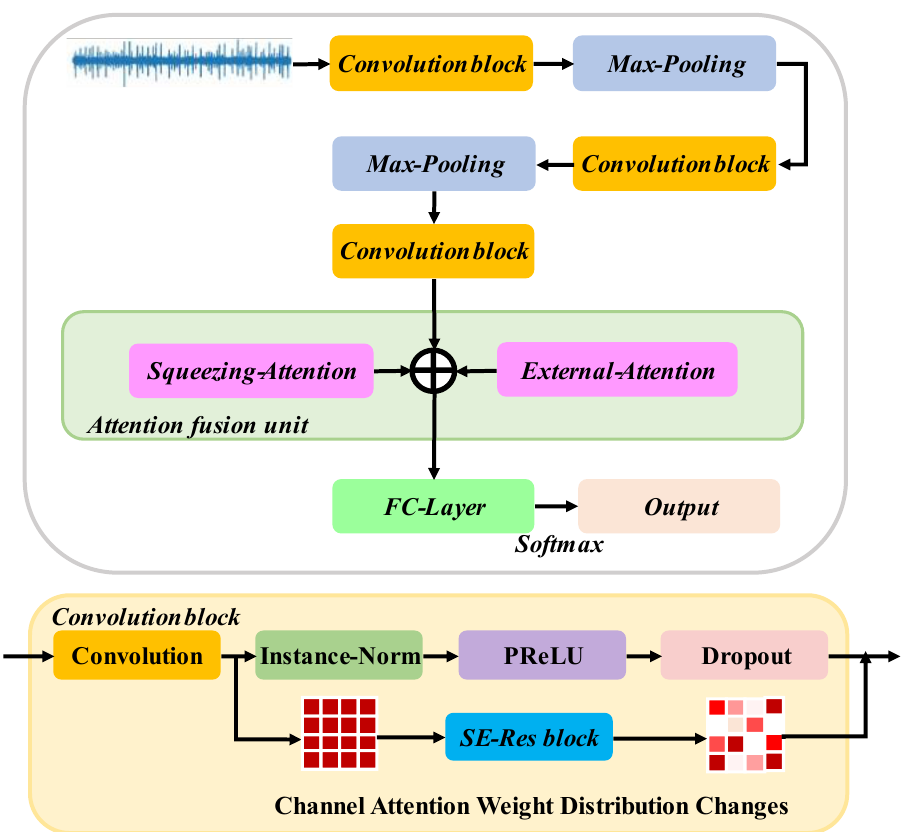
Figure 1. Figure 1. SRMANet.